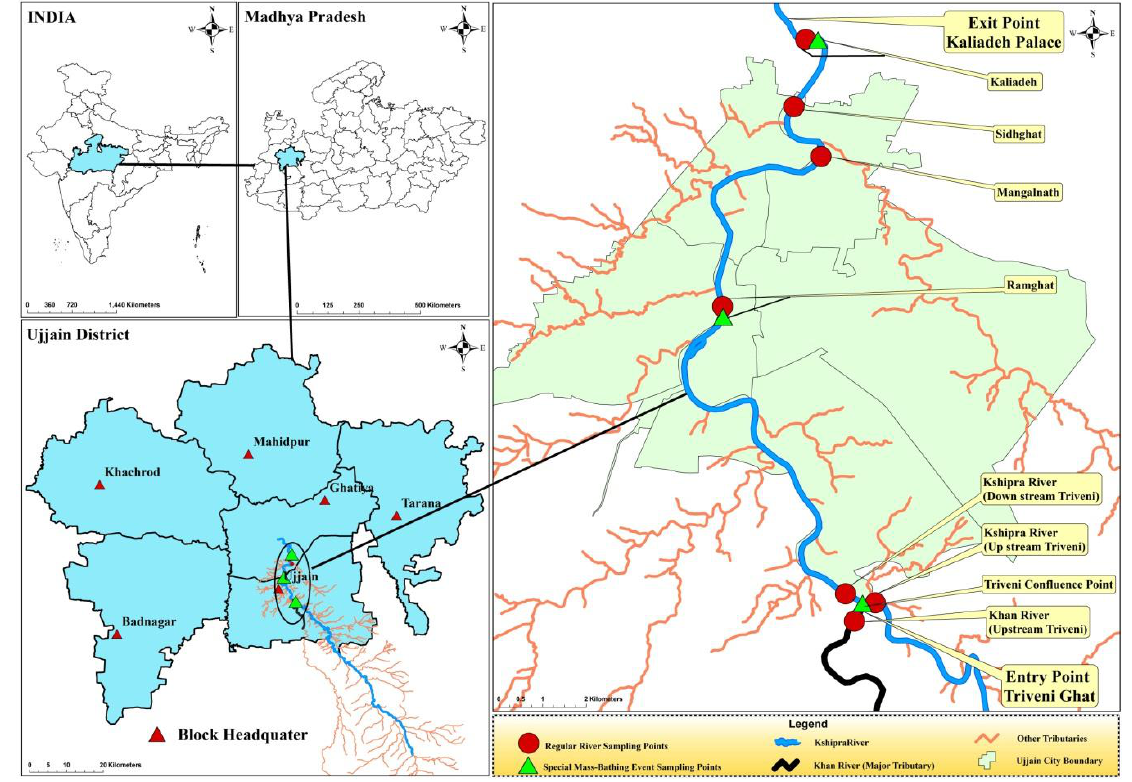
Figure 1. Geographical location of the sites for regular and mass-bathing sampling. The map shows (clockwise) India, Madhya Pradesh, Ujjain District and the sampling points for the Kshipra River, respectively.